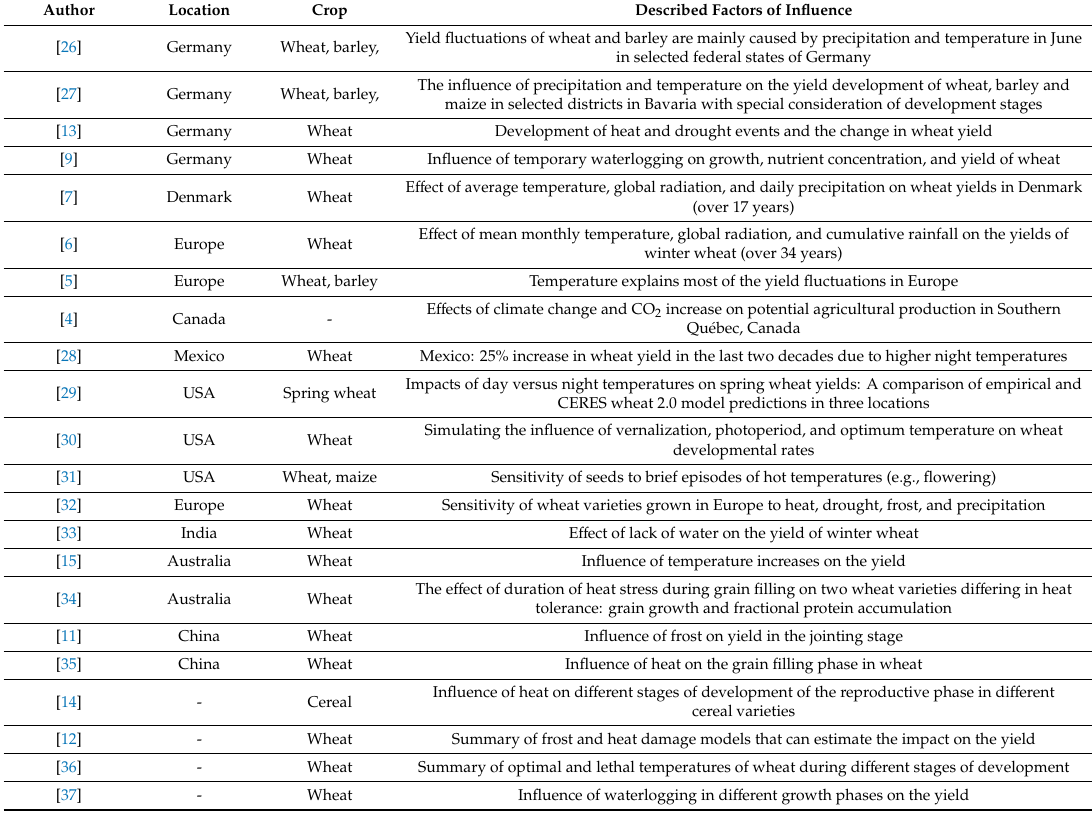
Table 1. Literature overview of various studies investigating the influence of climate on grain